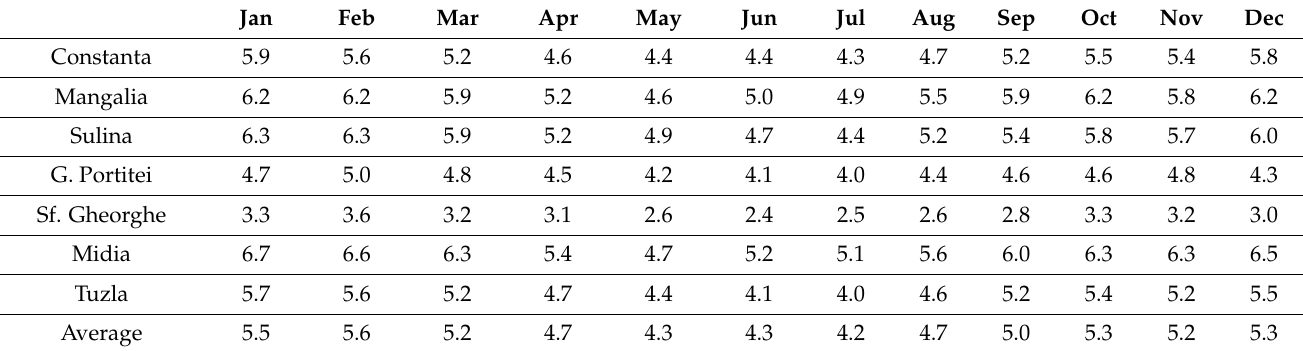
Table 2. Mean monthly values of the wind speed.